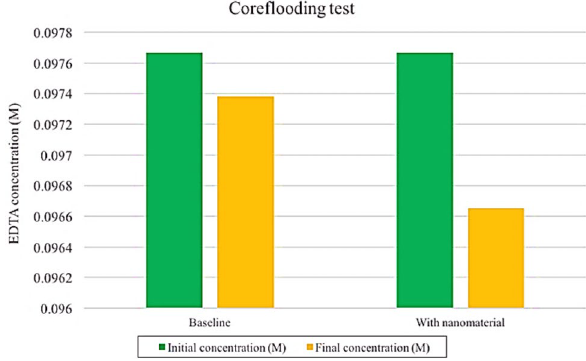
Fig. 6 Concentration of EDTA before and after shut in for 24 h